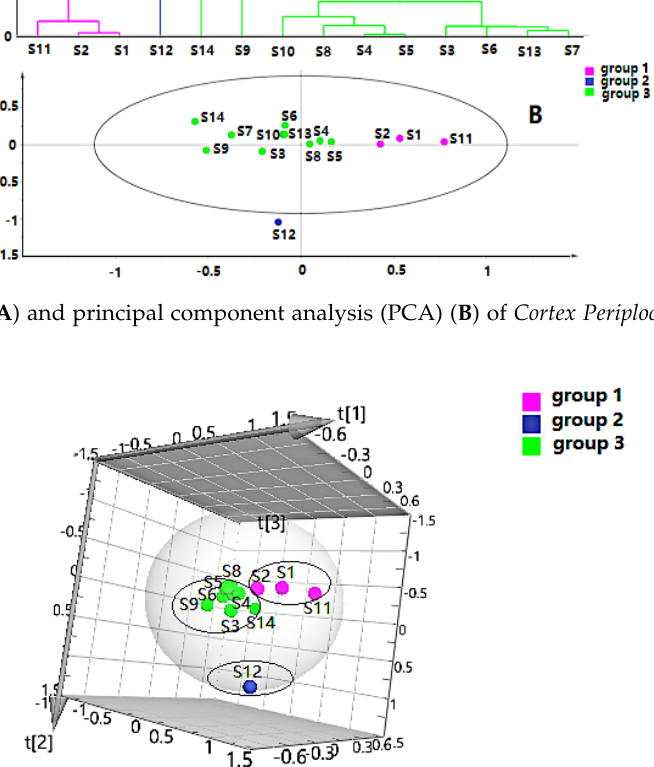
Figure 7. TIC of the sample, based on gas chromatography–mass spectrometry (GC-MS).